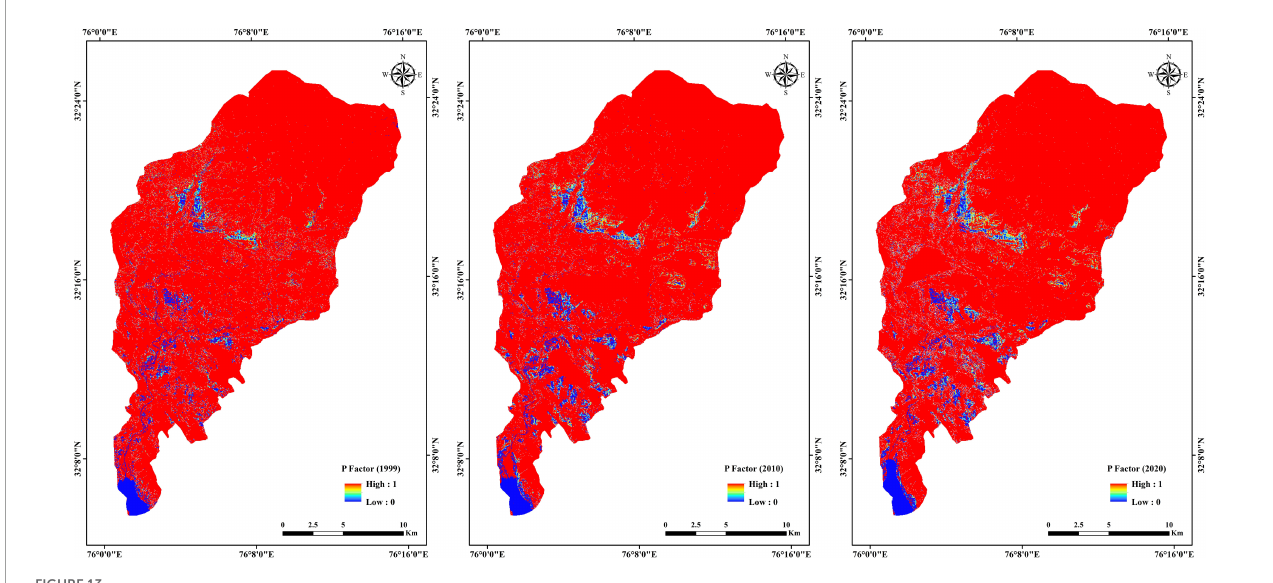
FIGURE13 Maps showing P factor of the Dehar watershed for the years 1999, 2010, and